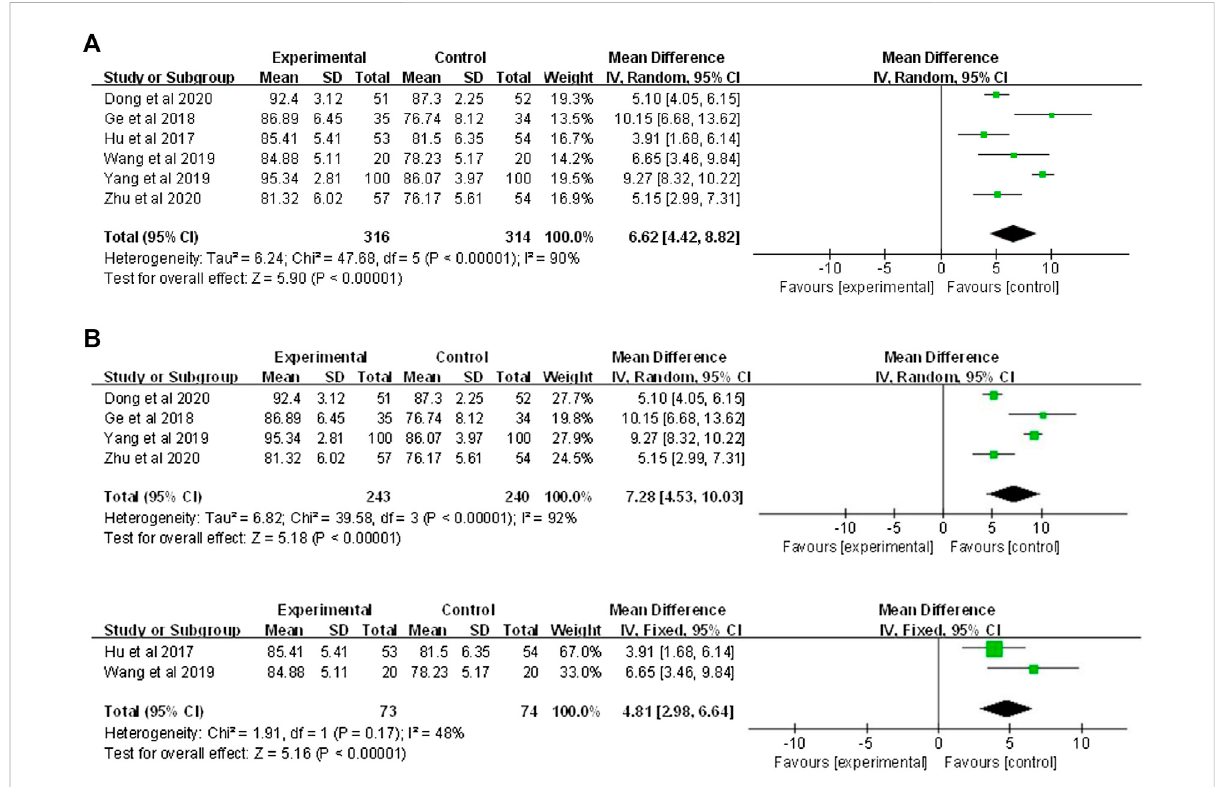
FIGURE 4 Forest plot for effectiveness of FC versus LBL in (A) experimental test score; (B) undergraduate versus 3-year junior-college student subgroup